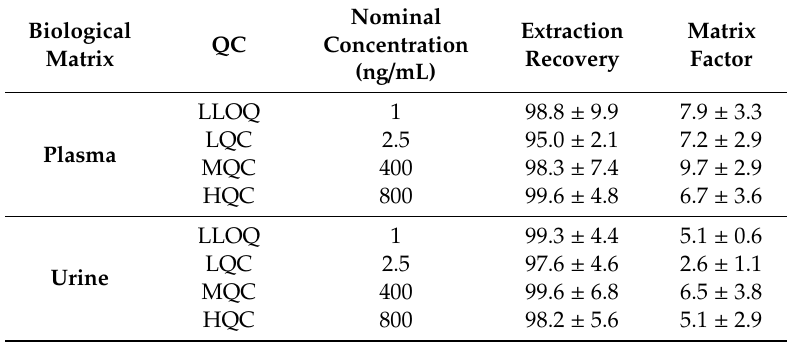
Table 3. Percentage extraction recovery and matrix factor for the quantification of GMC1 using